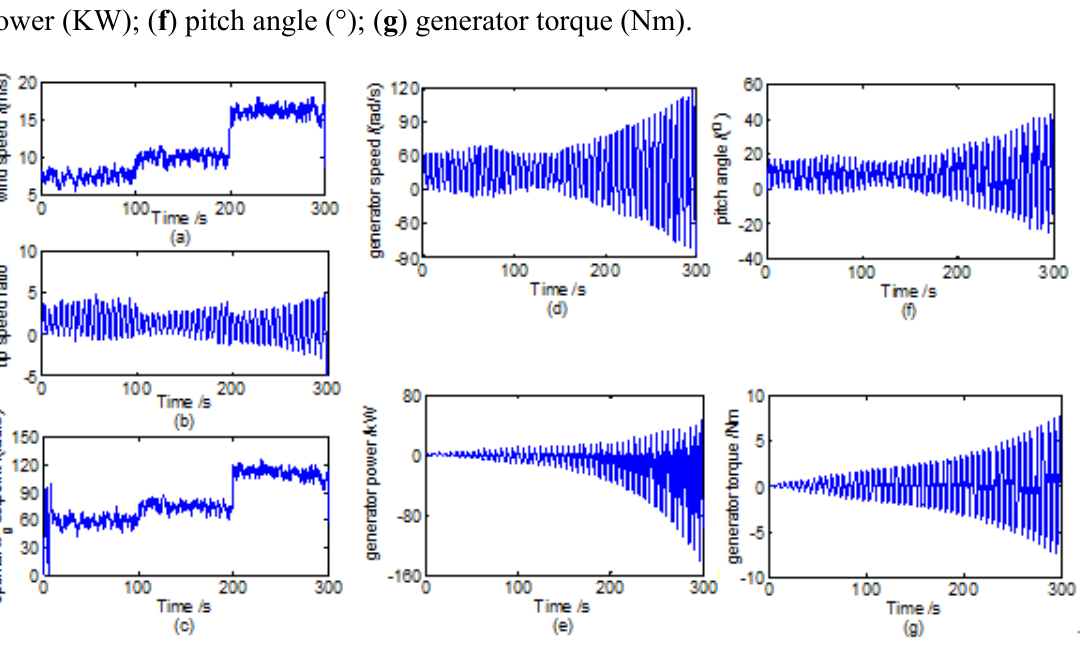
fault tolerant control for sensors fault of WECS: ( a ) wind speed (m/s); Figure 9. (cid:1834) (cid:2998) ( b ) tip speed ratio; ( c ) optimal (cid:2033) set point (rad/s); ( d ) generator speed (rad/s); ( e ) generator (cid:3034) power (KW); ( f ) pitch angle (°); ( g ) generator torque